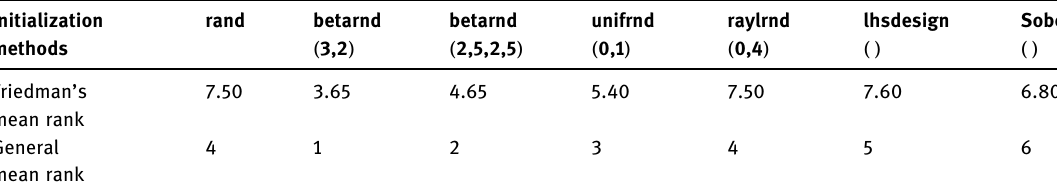
Table 9: Friedman ’ s test mean rank for CEC 2020